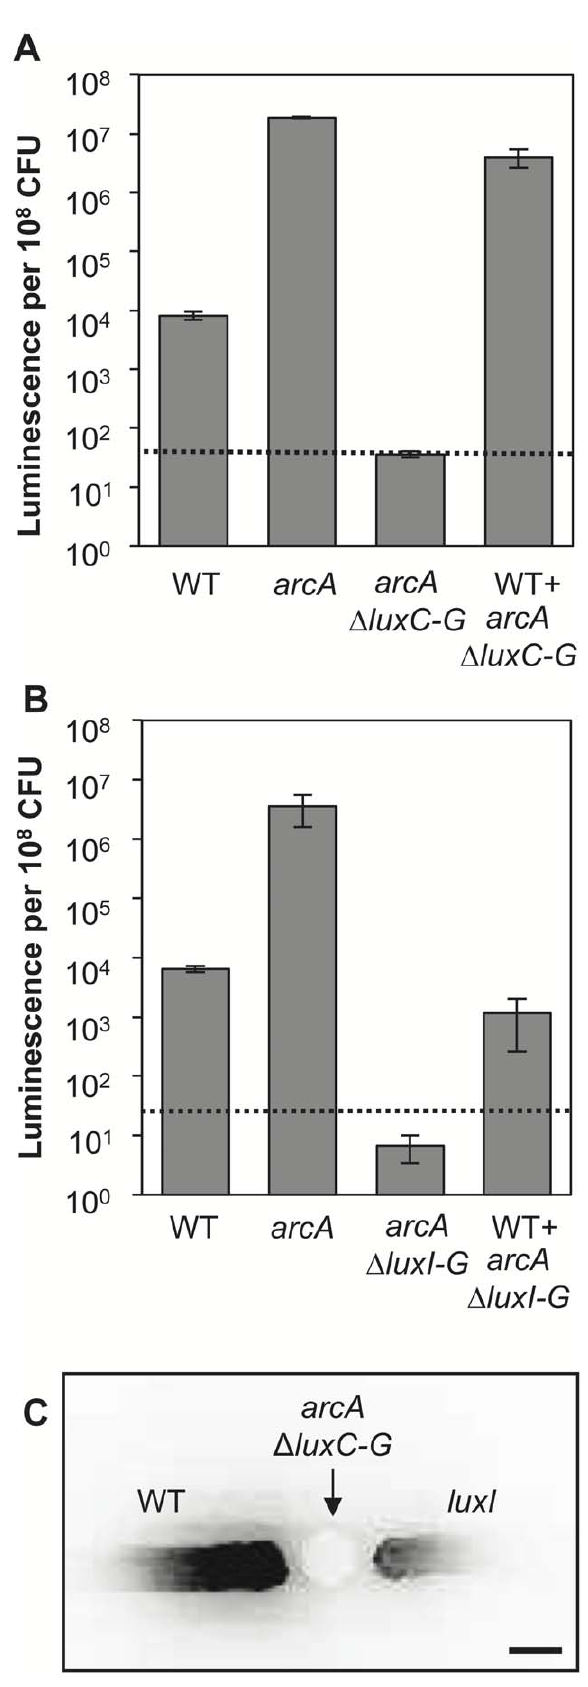
Figure 4. Inter-strain bioluminescence induction in mixed and spatially separated arcA + and arcA mutant cells. Wild-type cells were mixed with either the dark arcA D luxCDABEG strain (JB33) able to produce 3OC6 (A) or the dark arcA D luxICDABEG strain (ANS6) lacking the luxI 3OC6 synthase gene (B). Wild-type and arcA mutant cultures and co-cultures were grown in SWTO broth in duplicate aerobic shake flasks to peak luminescence. A sample was removed and dilution plated to determine the CFU ml 2 1 and the percent of wild-type cells in each co-culture (52% for A, 68% for B). Luminescence values are presented as luminescence per 10 8 CFU. Luminescence values presented for co- cultures are luminescence per 10 8 wild-type CFU. (C) Cultures of wild type or the luxI mutant were streaked onto SWTO agar plates next to spotted culture of the dark arcA D luxCDABEG strain (JB33) able to produce 3OC6. Inoculated plates were incubated at room temperature overnight and negative images of bioluminescence were captured with a BioRad Fluor-S MultiImager. Scale bar indicates approximately 5